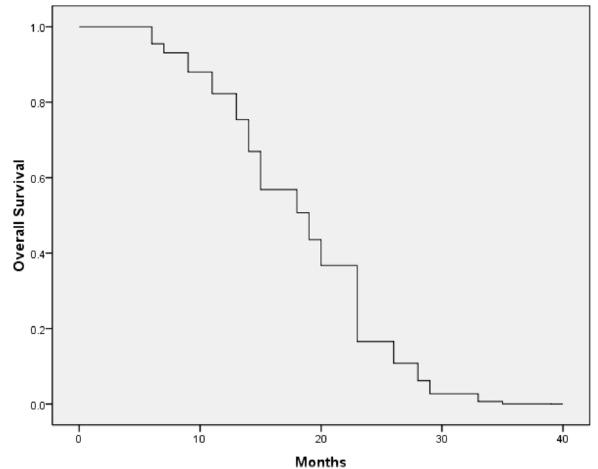
Figure 2. Treatment results and dosimetry plots of one